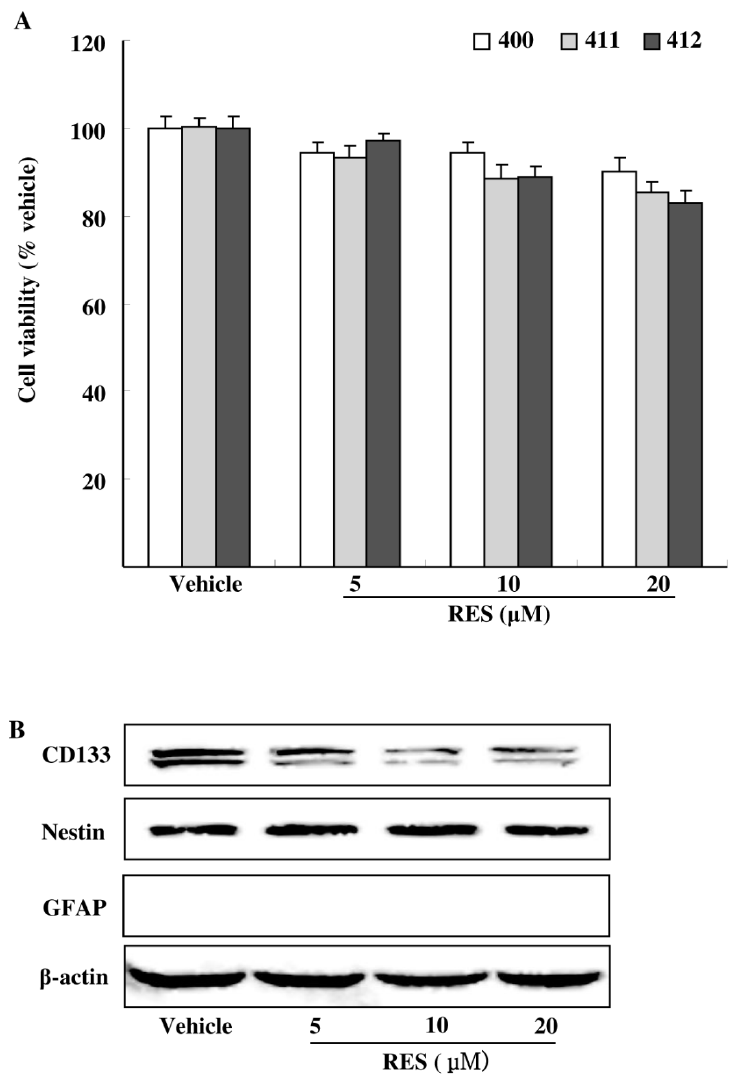
Figure 2. Effects of RES on the viability and stemness of GICs. ( A ) GICs (400, 411, 412) were treated with dimethyl sulfoxide (DMSO, vehicle) and 5 μM, 10 μM, and 20 μM RES for 48 h, respectively. Cell viability was examined by the MTT assay; ( B ) Representative GICs (412) were treated with DMSO (vehicle) and 5 μM, 10 μM, and 20 μM RES for 48 h, respectively. CD133, Nestin and GFAP were investigated by Western blotting analysis. PC-12 lysate was used as the positive protein of GFAP (results shown in Supplementary